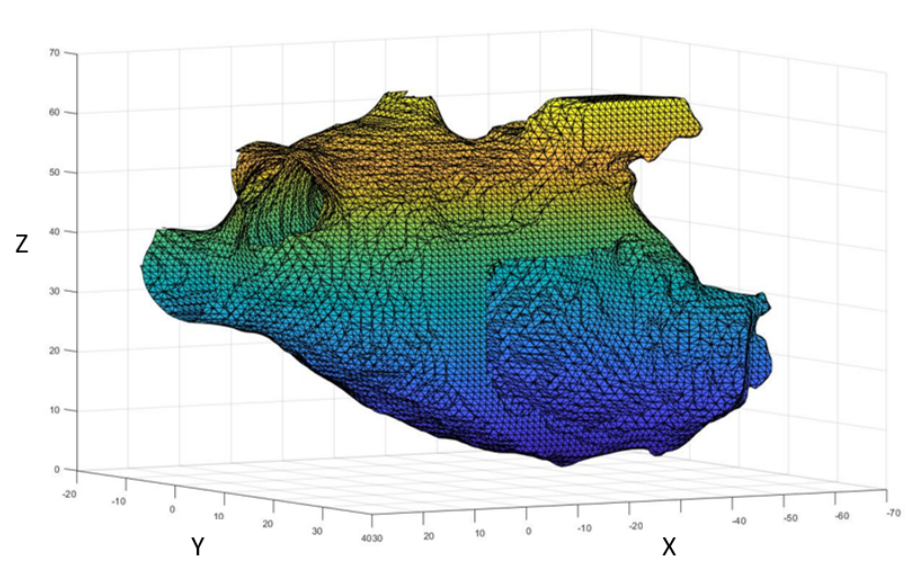
Figure 3. Three dimensional left atrial mesh generated from MRI